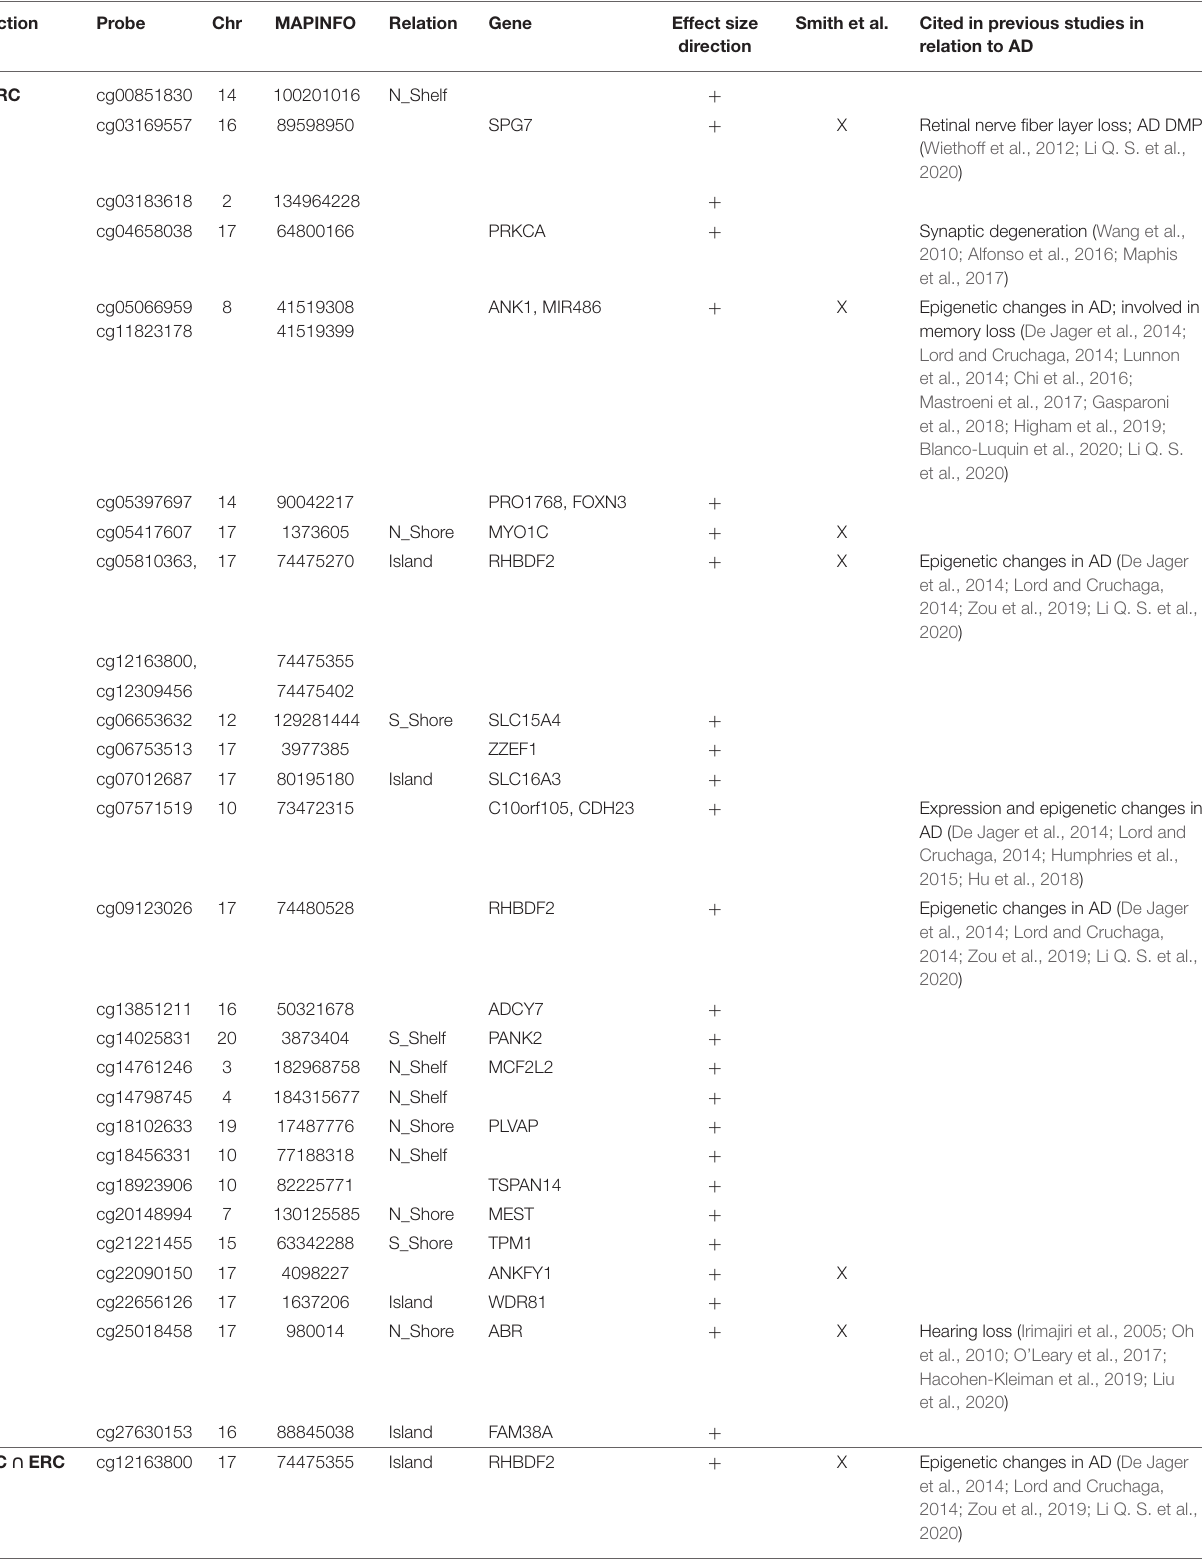
TABLE 5 | AD-DMPs resulting from cross-region analysis. Intersection